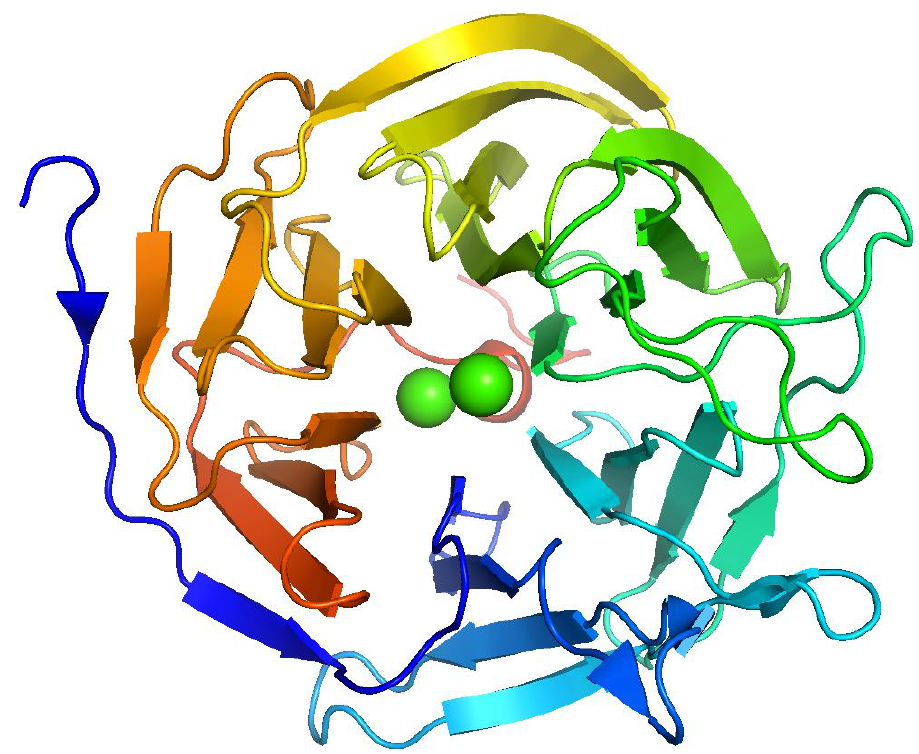
Figure 1. DFPase from Loligo vulgaris (PDB ID 3O4P, resolution 0.85 Å) [72]: six foursomes of antiparallel β-sheets (six blades) create the central tunnel containing two calcium ions (green); coloured from the N-terminal (blue) to C-terminal (red).